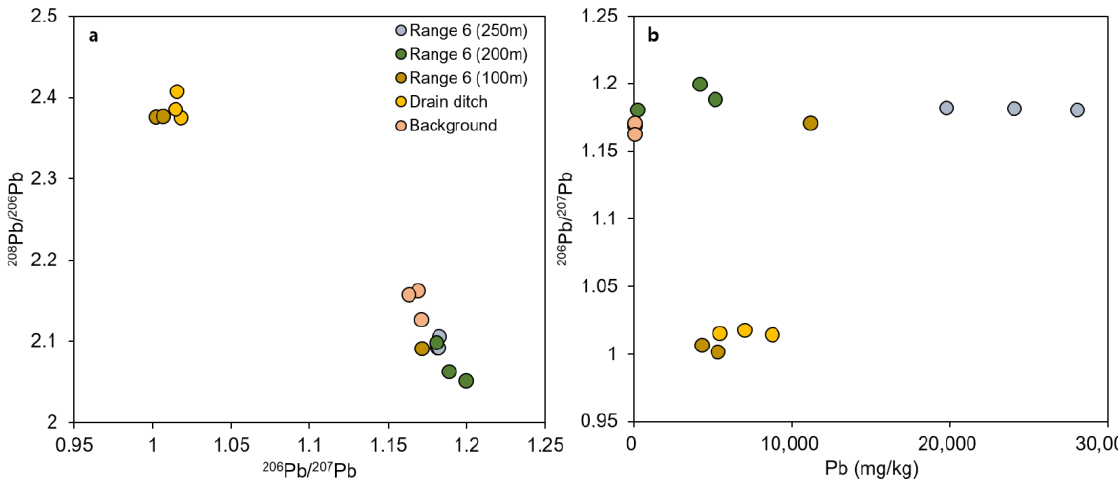
Figure 6. Plots of ( a ) 208 Pb/ 206 Pb vs. 206 Pb/ 207 Pb and ( b ) 206 Pb/ 207 Pb vs. Pb (mg/kg) for soils from 6th lane of shooting range with drain ditch and